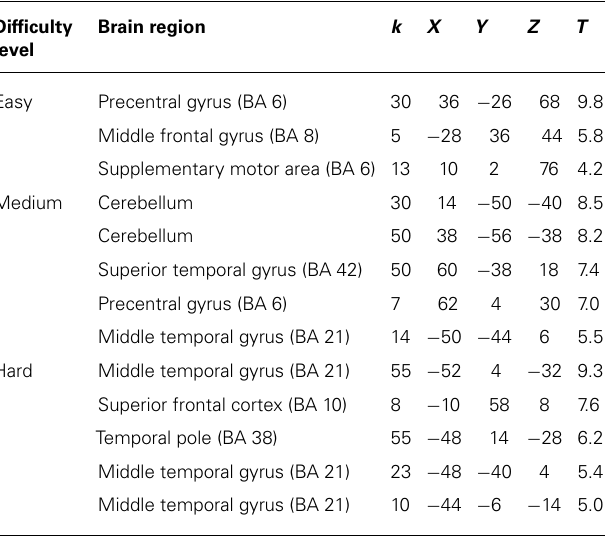
the brain.The functional brain response is overlaid on a rendered standardized brain (MNI-space) with a threshold of 0.005 uncorrected only showing clusters with a minimum of five voxels.